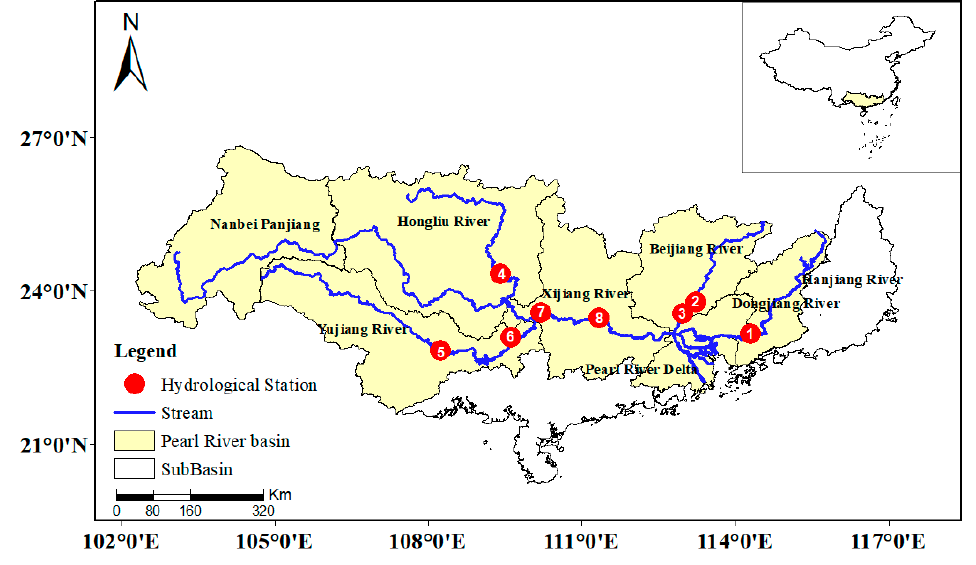
Figure 1. Research area of PRB in China. Table 1. Information of main hydrological stations in the PRB. Num.